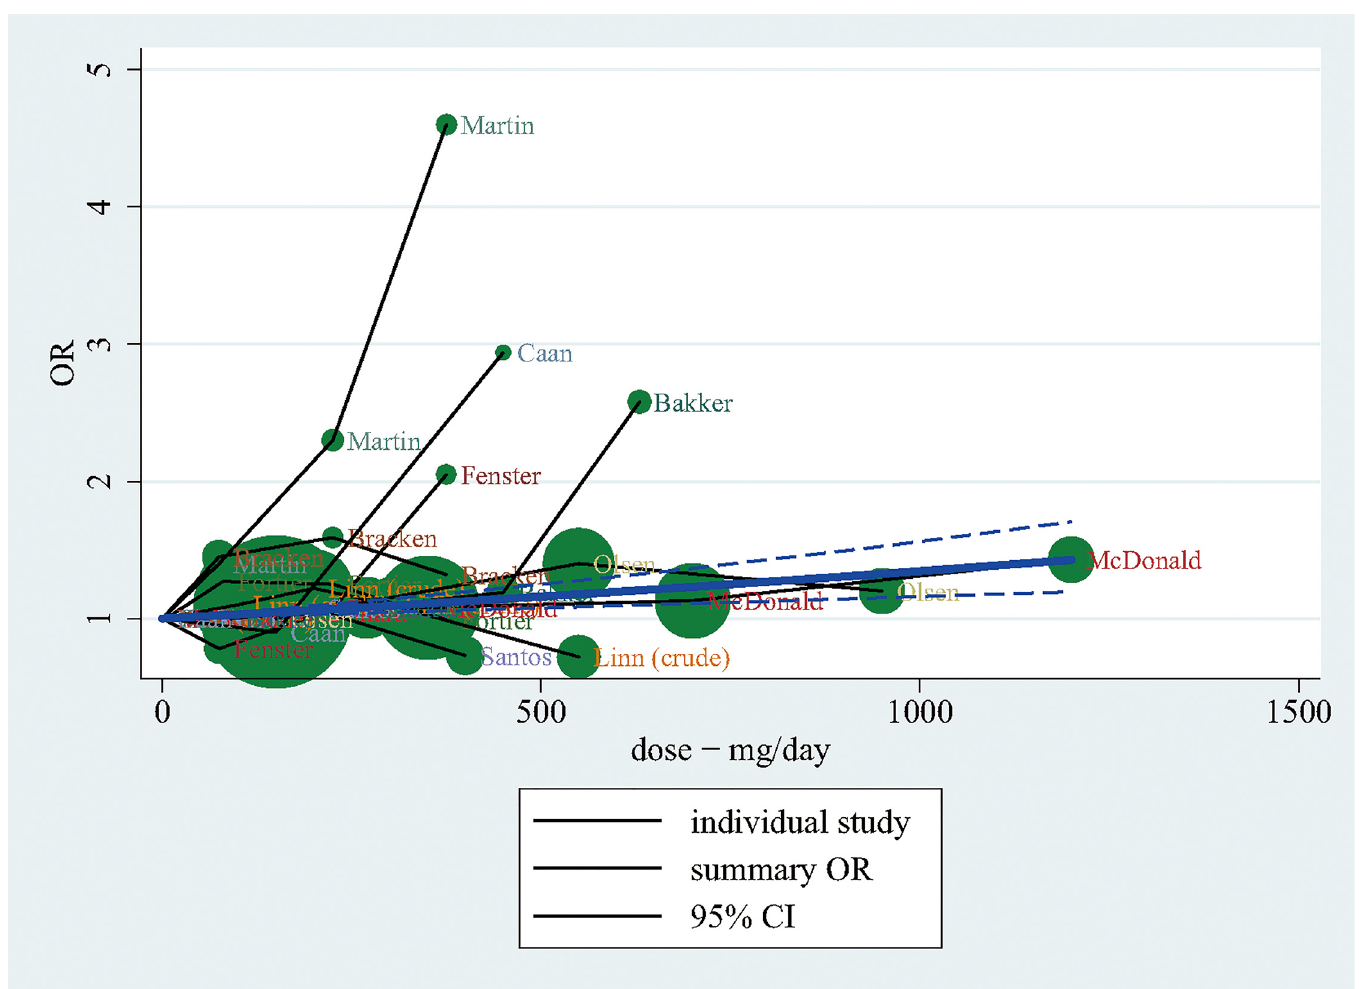
Fig 5. Linear dose-response analysis on the effect of caffeine intake during pregnancy on low birth weight.